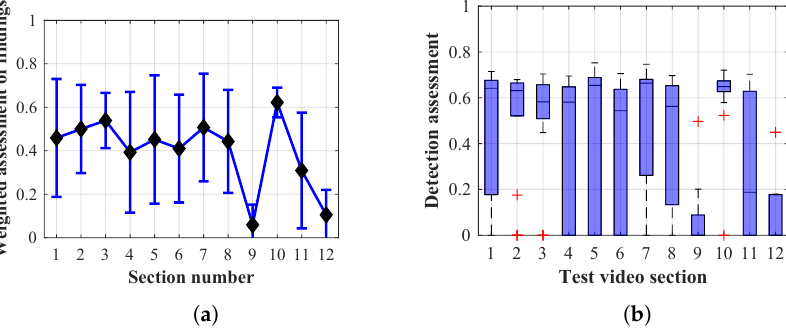
Figure 36. Results of Method 2.1 with a lifespan of 1 frames. ( a ) the weighted average rating with the average mean absolute error of the weighted rating and ( b ) boxplots of the distribution of the statistical sets of the results of the individual sections evaluated indicating: minimum, 1st quartile, median, 3rd quartile, maximum.